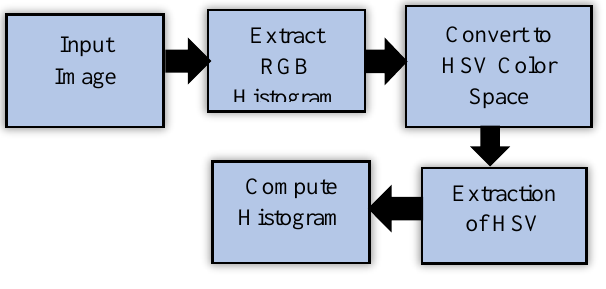
Fig. 3. Steps of Image